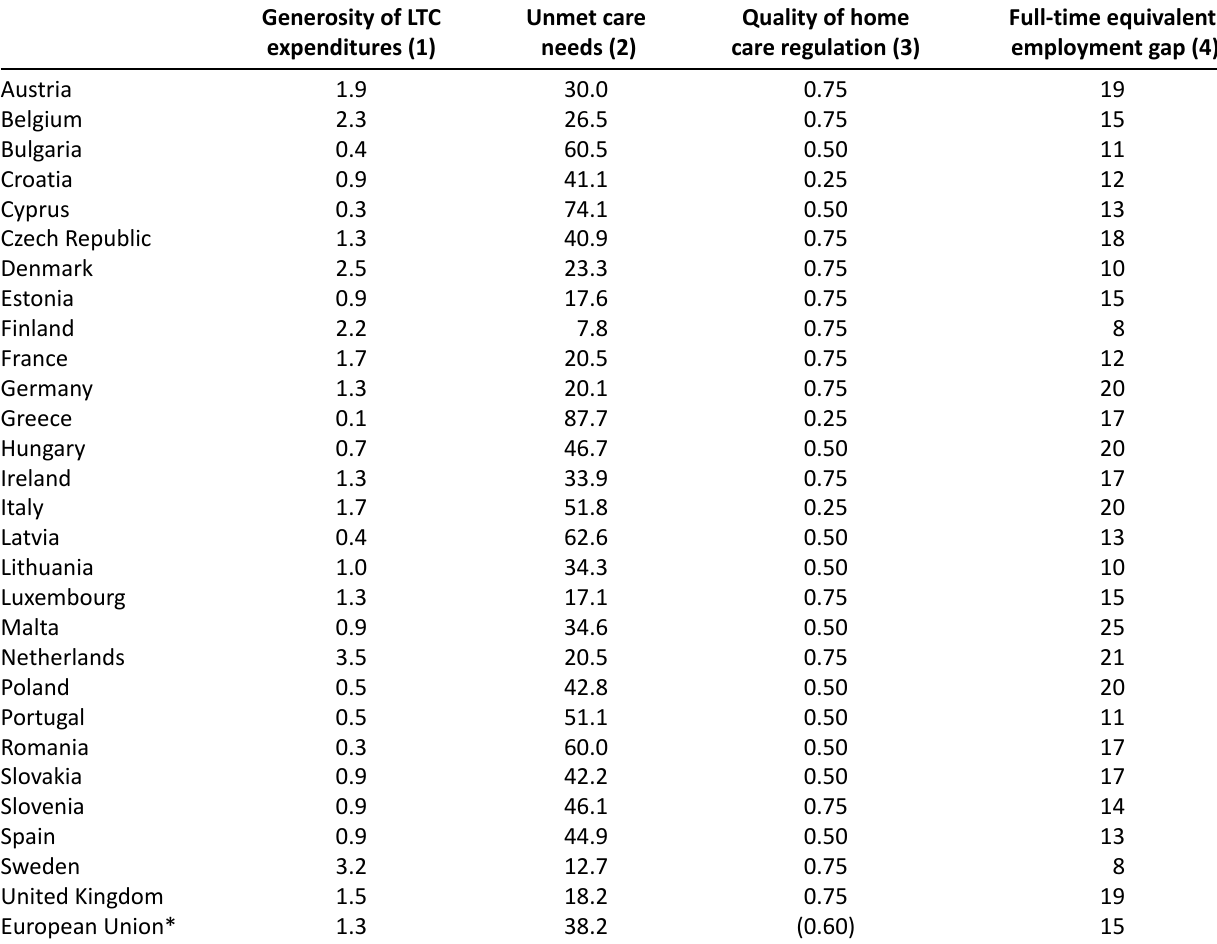
Table 2. Raw data used for the FSITA of European LTC